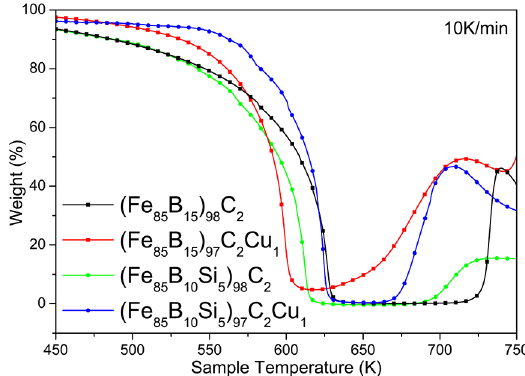
Figure 2. Thermogravimetry curves measurement by TGA, for the systems with different chemical composition, with different content of additions in the base